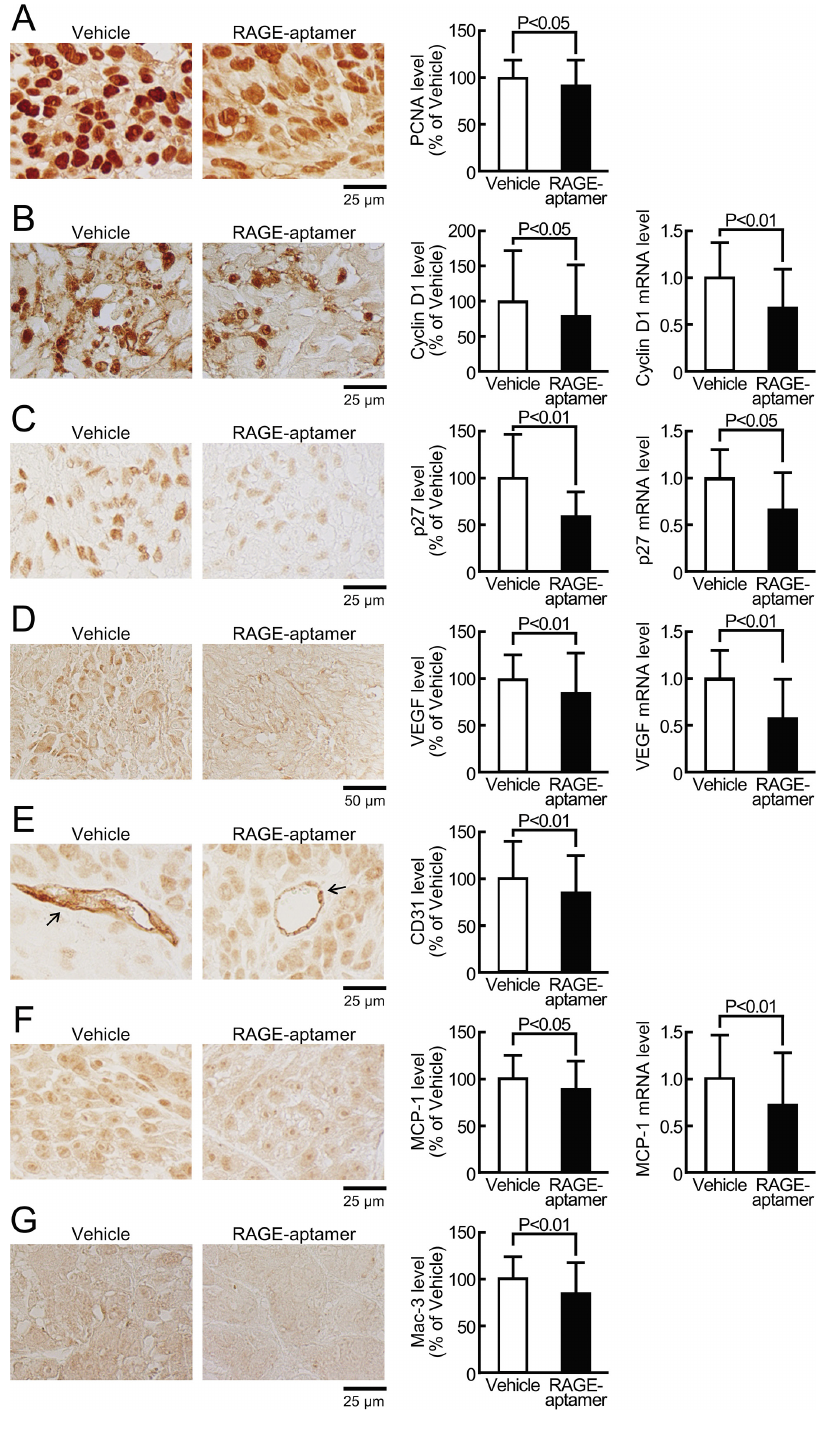
Figure 4. Effects of RAGE-aptamer on immunostaining of (A) PCNA, (B) cyclin D1, (C) p27, (D) VEGF, (E) CD31, (F) MCP-1 and (G) Mac-3 in G361 tumors. (A–G) Each left panel shows representative photographs of immunostaining. (E) Arrows indicate CD31-positive microvessels. Quantitative data are shown in each middle panel. (B) Cyclin D1 , (C) p27 , (D) VEGF and (F) MCP-1 mRNA levels in G361 tumors are shown in the rightmost panel.